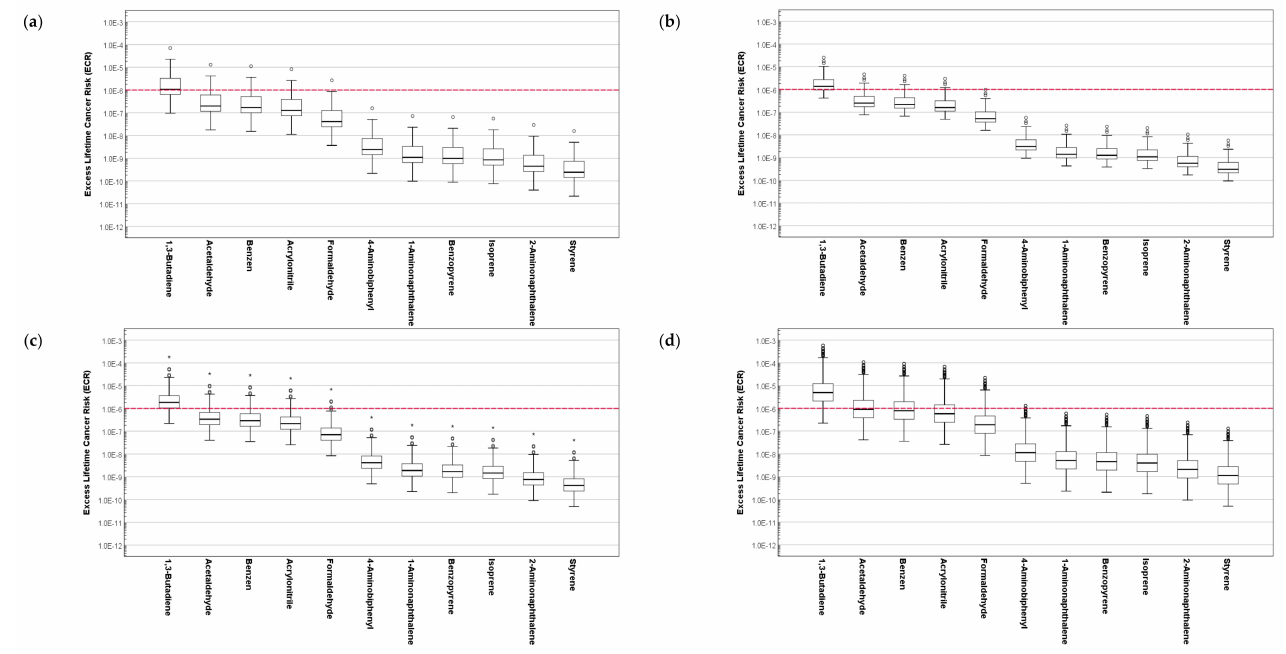
Figure 5. Assessment of excess lifetime cancer risk for the composition of cigarette smoke to SHS exposure subjects based on age: ( a ) 6–10 years old, ( b ) 11–13 years old, ( c ) 14–18 years old, and ( d ) 19 years old and